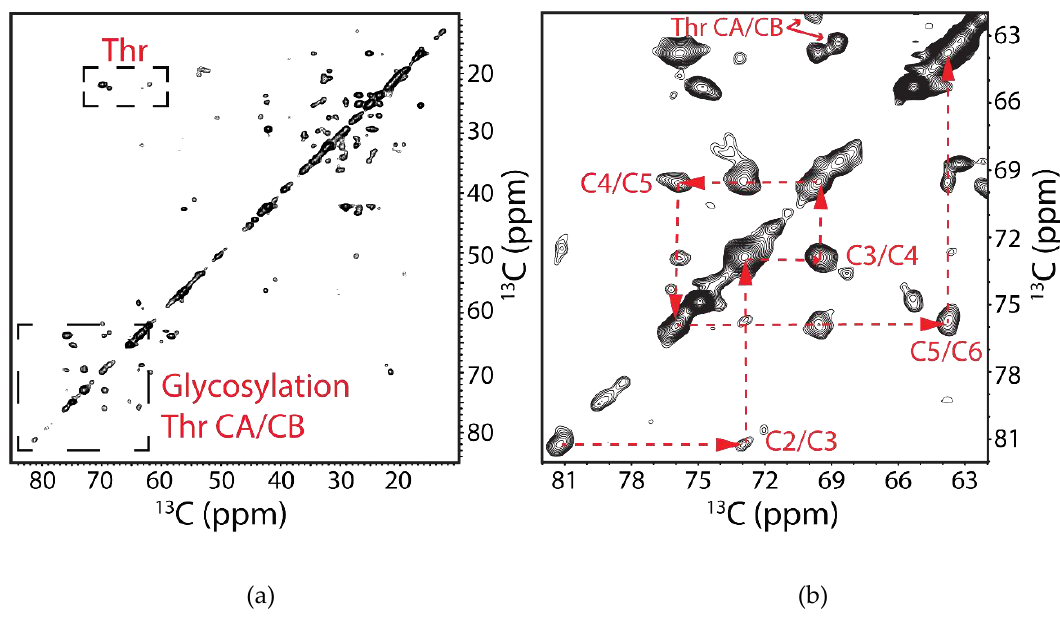
Figure 10. Two-dimensional 13 C– 13 C INEPT TOBSY chemical shift correlation spectrum of 13 C, 15 N- labeled hAQP2 proteolipid complexes at 800 MHz, at a spinning frequency of 14.3 kHz, and at 5 °C, showing the mobile parts of the protein and sugar moieties. ( a ) Spectrum between 10 and 85 ppm with the two regions of interest outlined in boxes. Signals corresponding to threonine CA/CG and CB/CG correlations as well the cross-peaks associated with glycosylation of hAQP2 are indicated. ( b ) Zoomed-in region between 62 and 82 ppm associated with the sugar cross-peaks with the spin system indicated with red dashed lines and labeled according to CASPER-determined α -D-mannose assignments. Data was processed with 40 Hz of Lorentzian line narrowing and 80 Hz of Gaussian line broadening in both dimensions. First contour level was cut at 5 × σ with each level multiplied by 1.1.